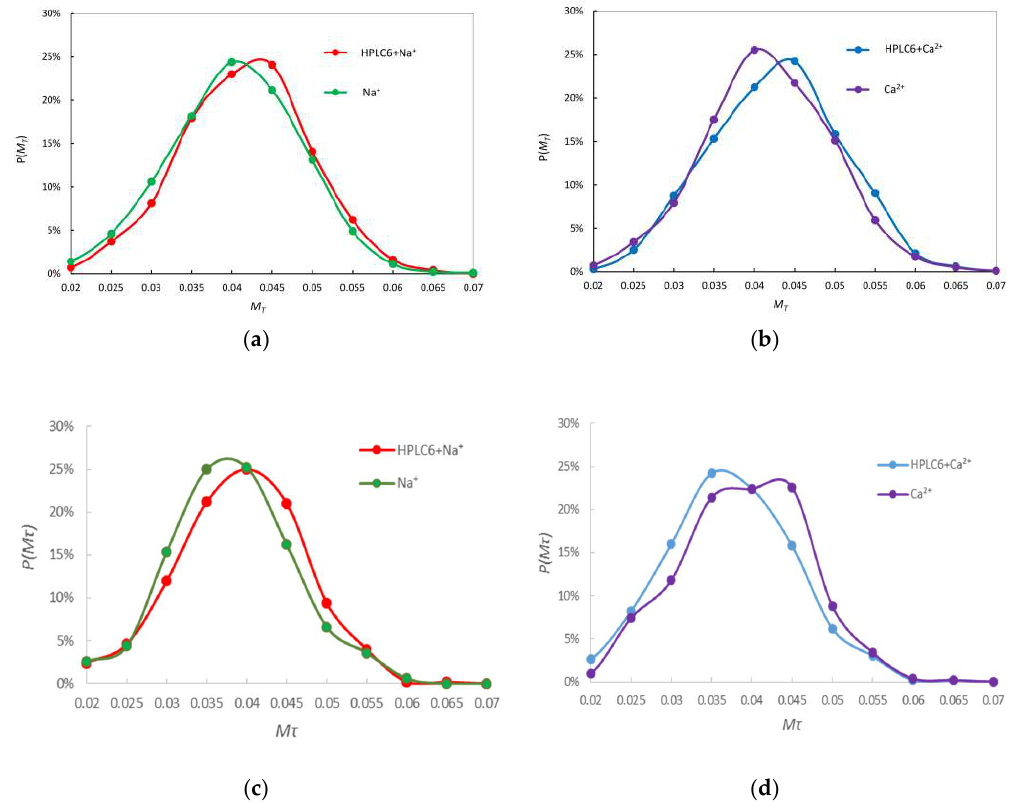
Figure 4. Distributions of the tetrahedricity parameter; ( a ) in the case with NaCl for 1500–1550 ps, ( b ) in the case with CaCl 2 for 1500–1550 ps, ( c ) in the case with NaCl for 1950–2000 ps, ( d ) in the case with CaCl 2 for 1950–2000 ps.